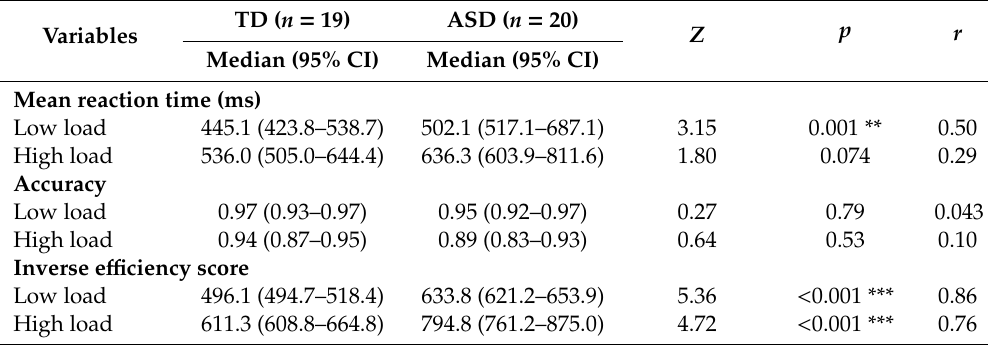
Table 3. n -back task performance in the typically developing (TD) and autism spectrum disorder (ASD)